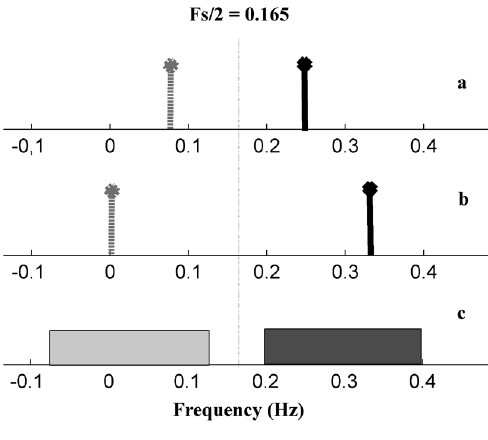
Figure 4: Actual and apparent frequencies due to aliasing for 0.25 Hz and 0.35 Hz narrow band signals and (0.2-0.4 Hz) wideband signals are depicted in plots a, b and c, respectively. Sampling frequency is considered to be 0.33 Hz.